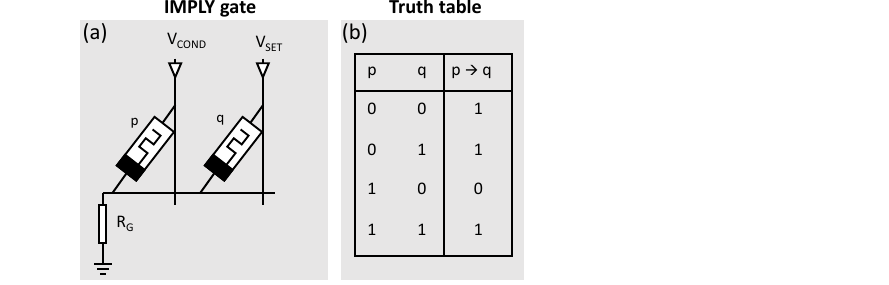
Figure 3. IMPLY gate: ( a ) schematic of a memristor-based IMPLY gate, ( b ) truth table of the IMPLY function.